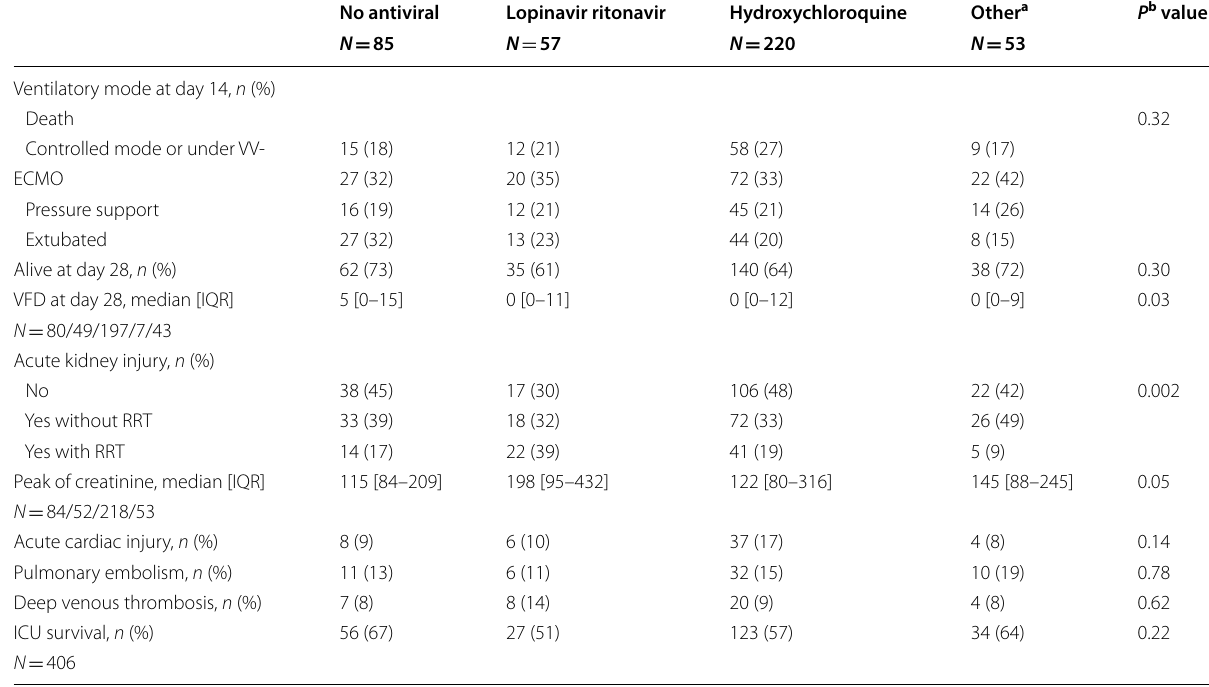
Table 2 Outcome according to antiviral treatment No antiviral Lopinavir